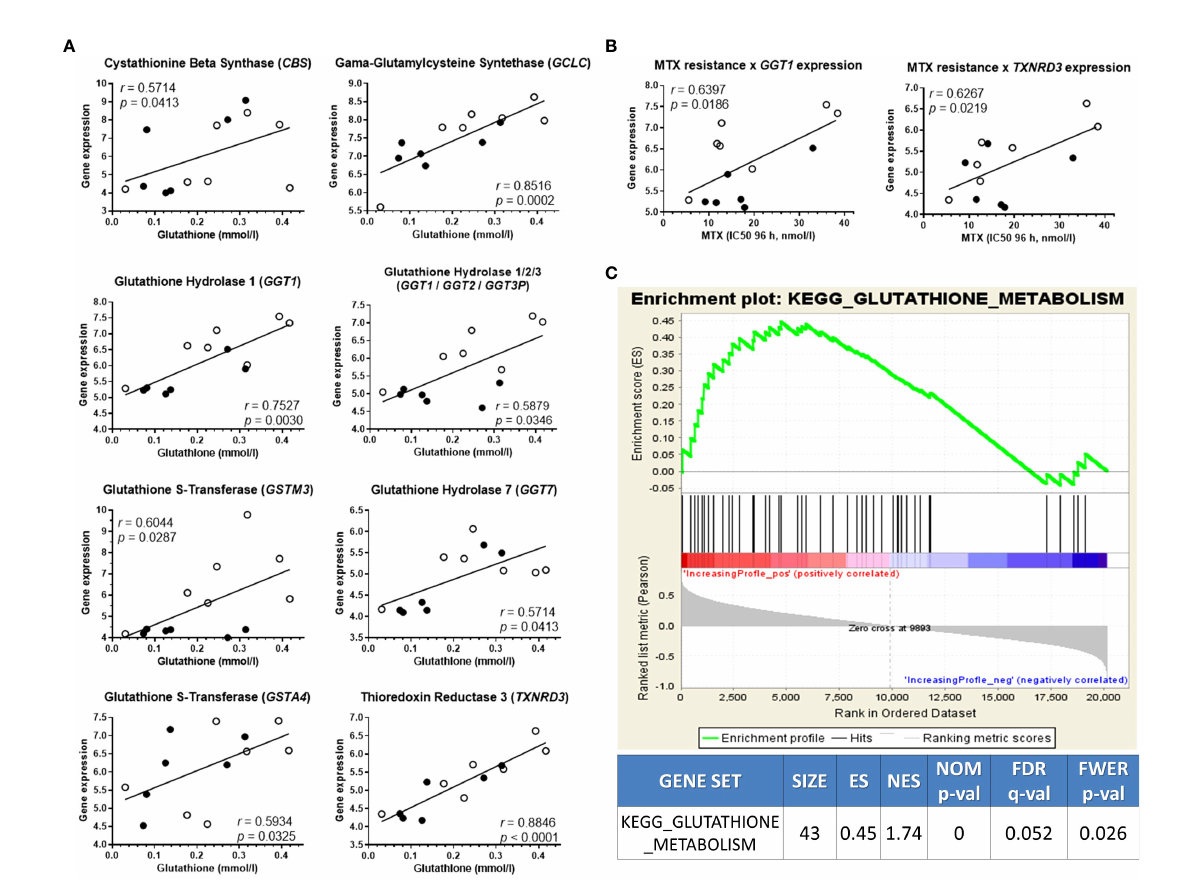
FIGURE 3 GSH-related transcriptome associates with metabolic levels and MTX resistance. (A) Association between glutathione (GSH) metabolism genes ’ expression and GSH concentration; (B) Gene set enrichment analysis score plot showing KEGG ’ s Glutathione Metabolism gene set enrichment in high-GSH ALL cell lines. (C) Expression of two GSH-related genes also correlated to MTX resistance. Black and white beads represent BCP- ALL and T-ALL cell lines, respectively. P -values and r are from Pearson